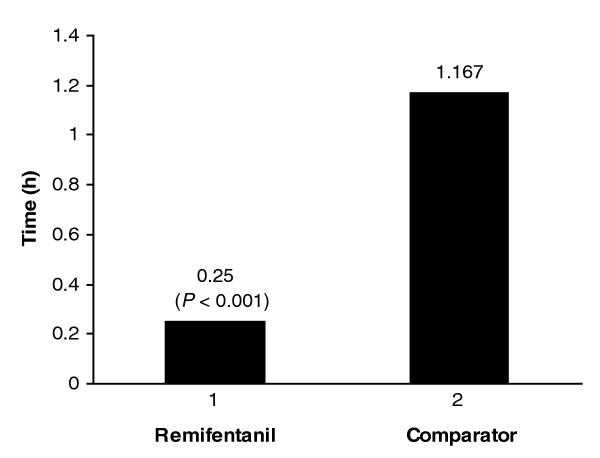
Median time to offset of effects as measured by the time to therapeutic intervention.